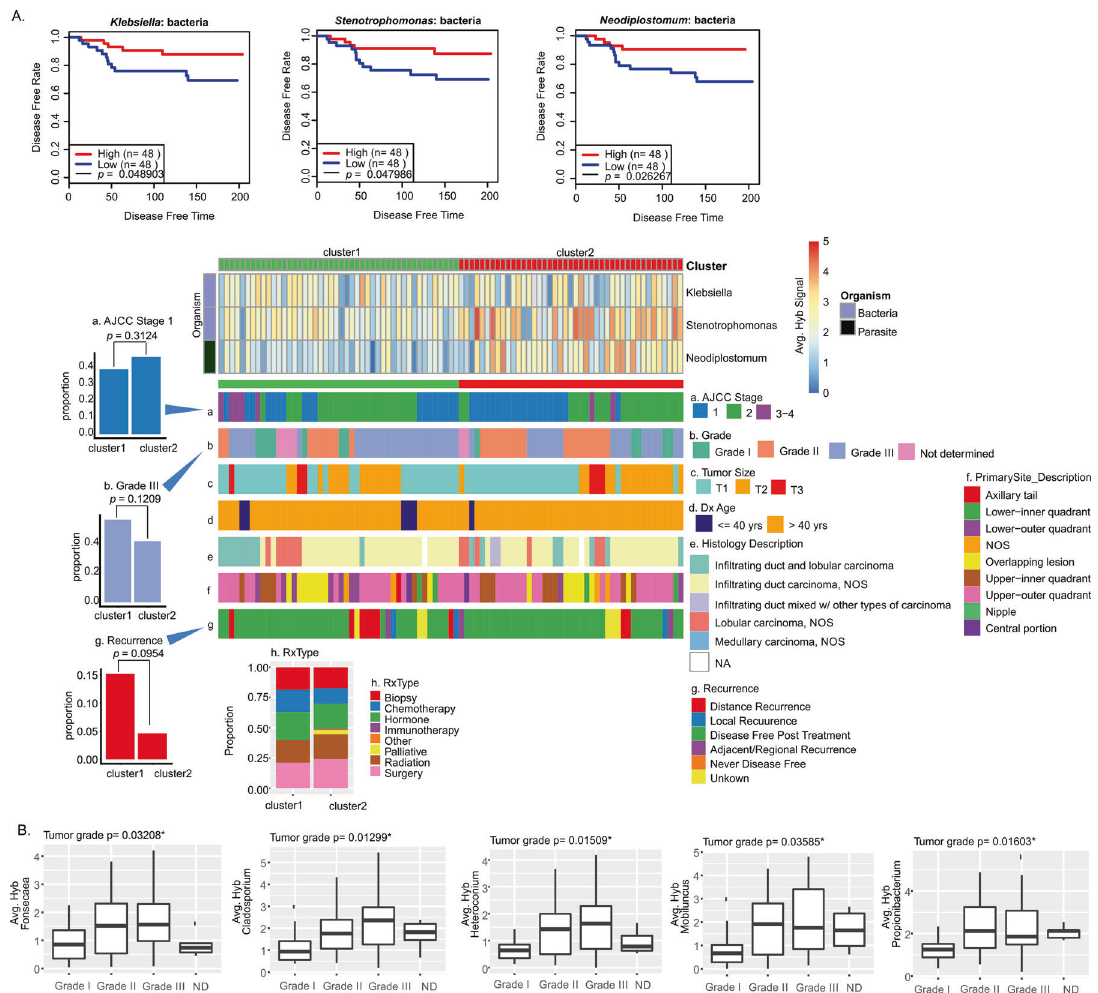
Fig. 5 Oncobiome signatures in ER + breast cancer where higher hybridization signals correlate with better disease outcome. A The graphs show disease-free rate relative to high or low hybridization signals for the speci fi c microorganisms in the tumor sample set. In the cases shown, higher hybridization signal correlated with increased disease-free time or survival. The tumor samples were then clustered based on the hybridization levels for these microorganisms. The high (cluster 1) and the low (cluster 2) hybridization detection clusters were correlated with other clinical data shown as horizontal ( a – g ) and vertical ( h ) cluster barplot. B Box plot showing average hybridization signal of microorganism detection in different tumor grades. ND not diagnosed. χ 2 p values showing signi fi cant ( p ≤ 0.05) differences in the hybridization signal for detection in different grades